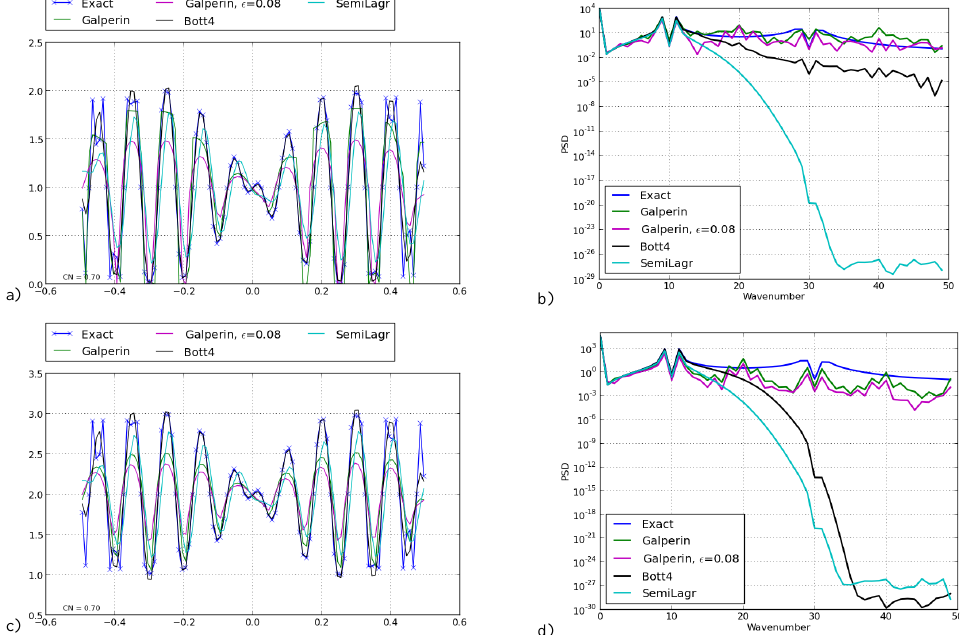
Figure 4. Example of input and output spectra for broadband input to the advection schemes with zero and nonzero background levels. Left panels: exact and numerical solutions. Right panels: power spectrum densities initially and after one revolution. Top: B = 0; bottom: B = 1 .